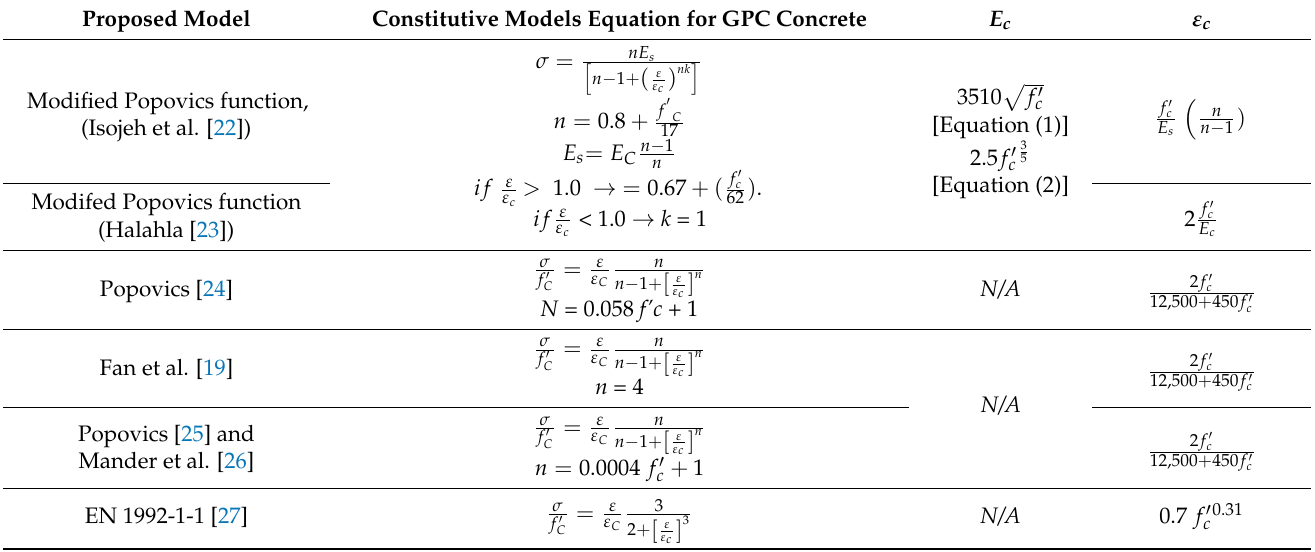
Figure 1. Parameter ‘n’ at different temperatures. Table 1. Constitutive models for GPC concrete in compression state.